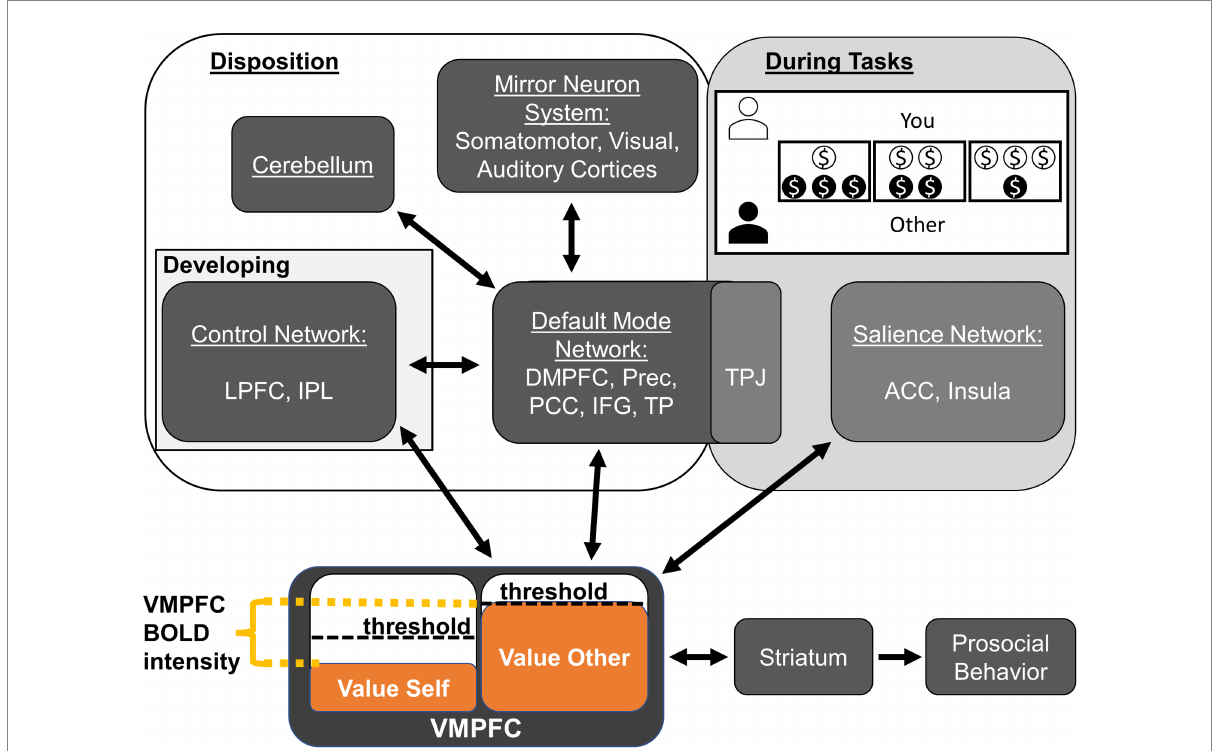
FIGURE 3 Revised Domain-General Developmental (Do-GooD) network model of prosocial cognition. We present a revised domain-general network model of prosocial cognition that expands on the previous model using the present findings in resting state brain networks. There are four key